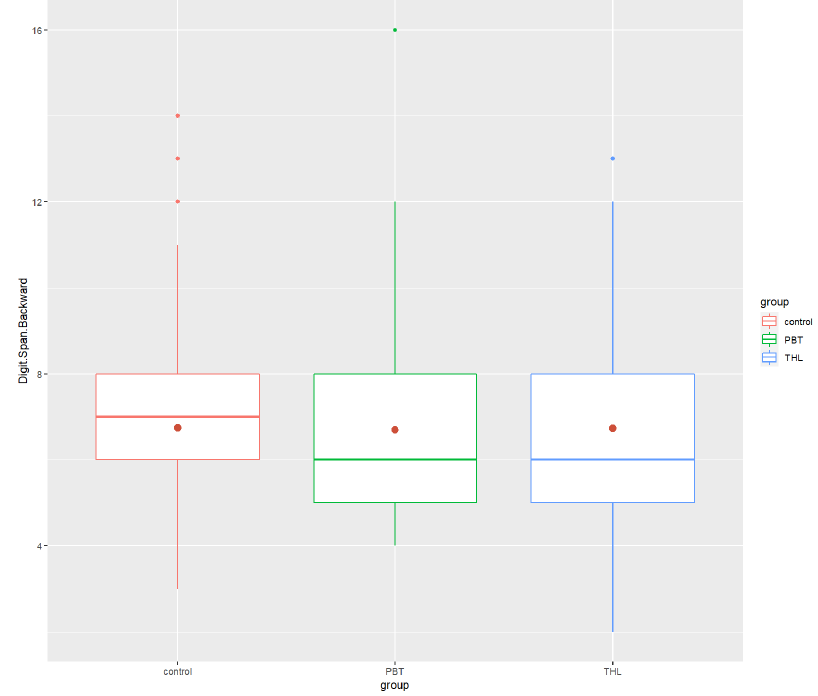
Figure 2. Boxplots of Digit Span Backward for the healthy control group and the diagnosis groups. Control — healthy control group, PBT — pediatric brain tumor survivors, THL — hematopoietic and lymphoid tissues tumor survivors. Red dot — mean test score for each group. Cancers 2022 , 14 ,